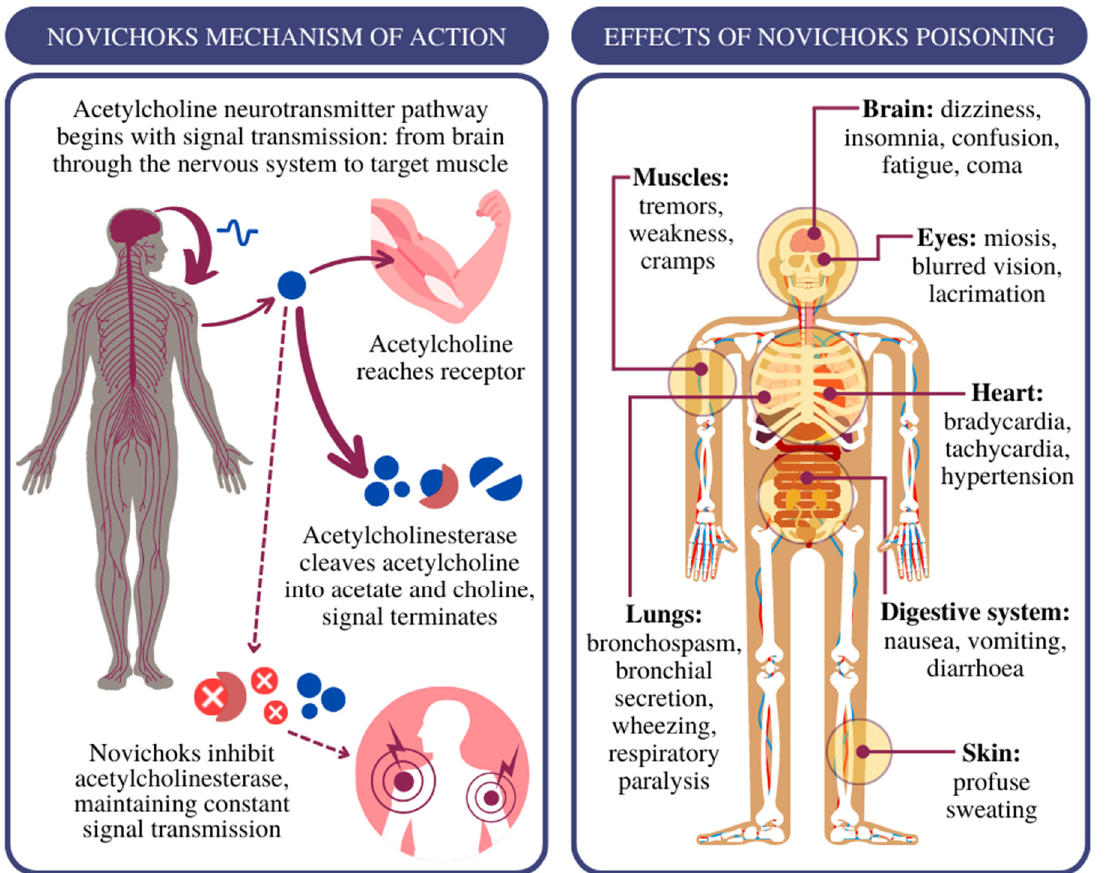
Figure 3. Left panel: the acetylcholine pathway in the cholinergic synapse and interaction with Novichok nerve agents; Right panel: effects of acute poisoning with nerve agents [7,11].